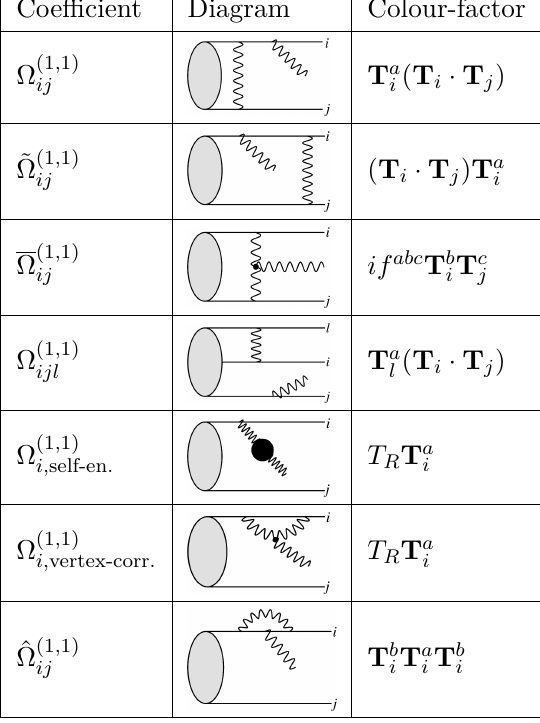
Table 2 . One-loop, one-emission diagram